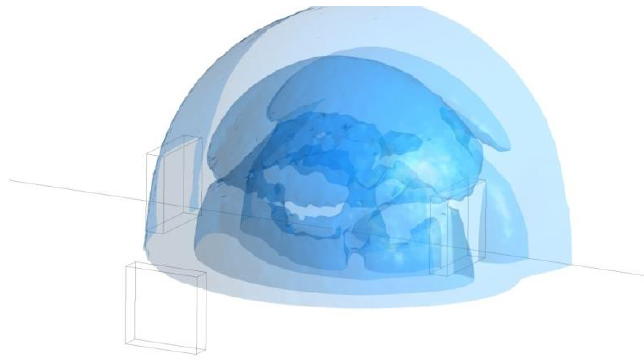
Figure 13. Display of an isobaric surface with a pressure of 2 kPa in a time of 10 ms.